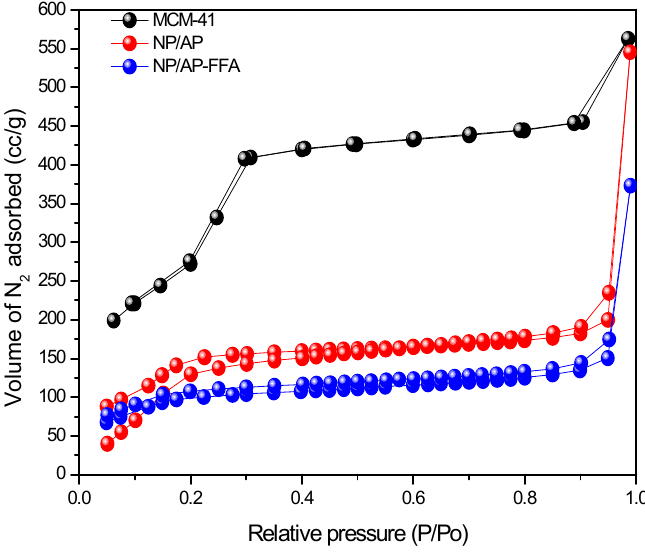
Figure 2. Isotherm of MCM-41, MCM-41/AP and MCM-41/AP-FFA.